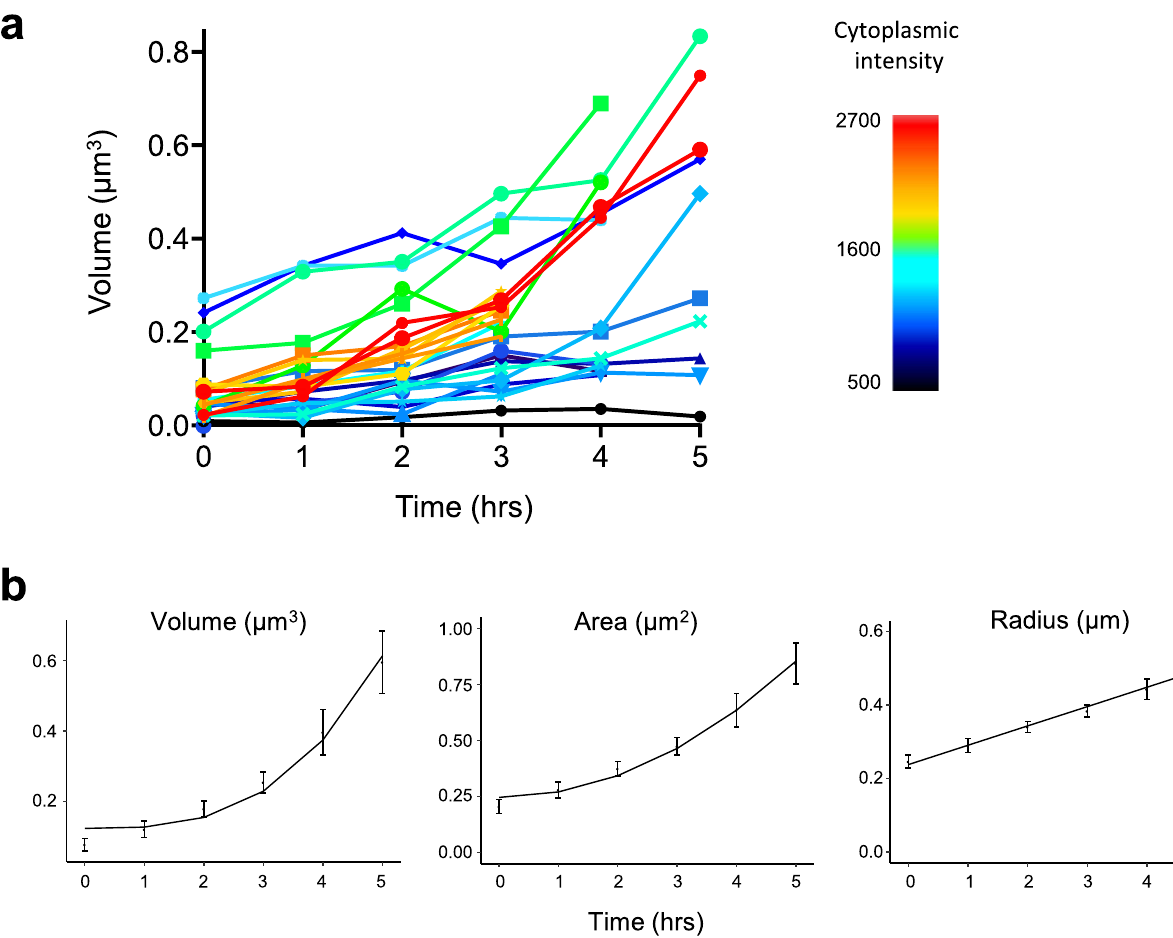
Fig. 8 Inclusion body growth rate increases with cytoplasmic mHtt concentration and is proportional to the surface area. a The measured volume of 25 inclusion bodies (IBs) over 3-5 h. The growth curves were aligned to the time of the fi rst observation of each IB. The color of each IB trace indicates the average cytoplasmic intensity of the cell containing the IB (bar, right). b Average IB volume, area, and radius are plotted over time for the 16 IBs in cells with cytoplasmic intensities >1100 (error bars indicate SEM). Fits of the growth of volume with t 3 ( R 2 = 0.97), an area with t 2 ( R 2 = 0.98), and a radius with t ( R 2 = 0.99) are shown. If the growth of the radius with time is linear, it follows that the growth of area will grow as t 2 , and volume will grow as t 3 .